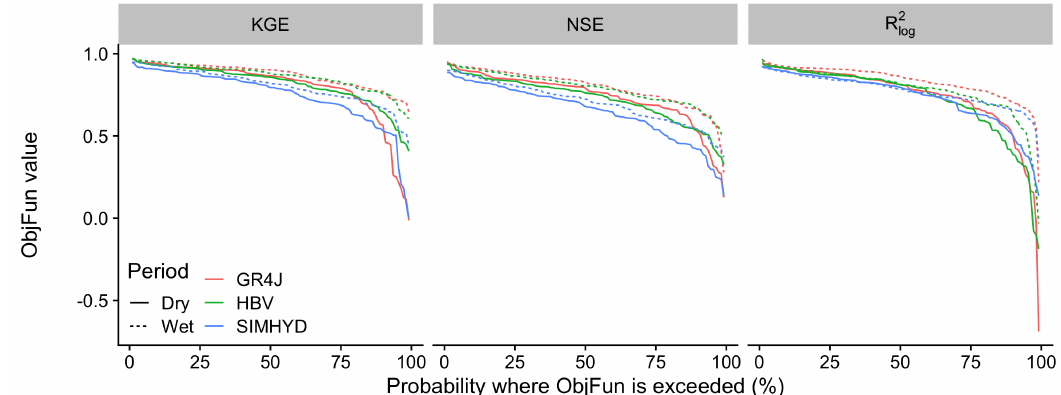
Figure 2. Probability of exceeding a specific objective function value across the catchments. Objective functions are in different panels and the models used for calibration are in different colours. The dry period is a solid line and the wet period is a dashed line.